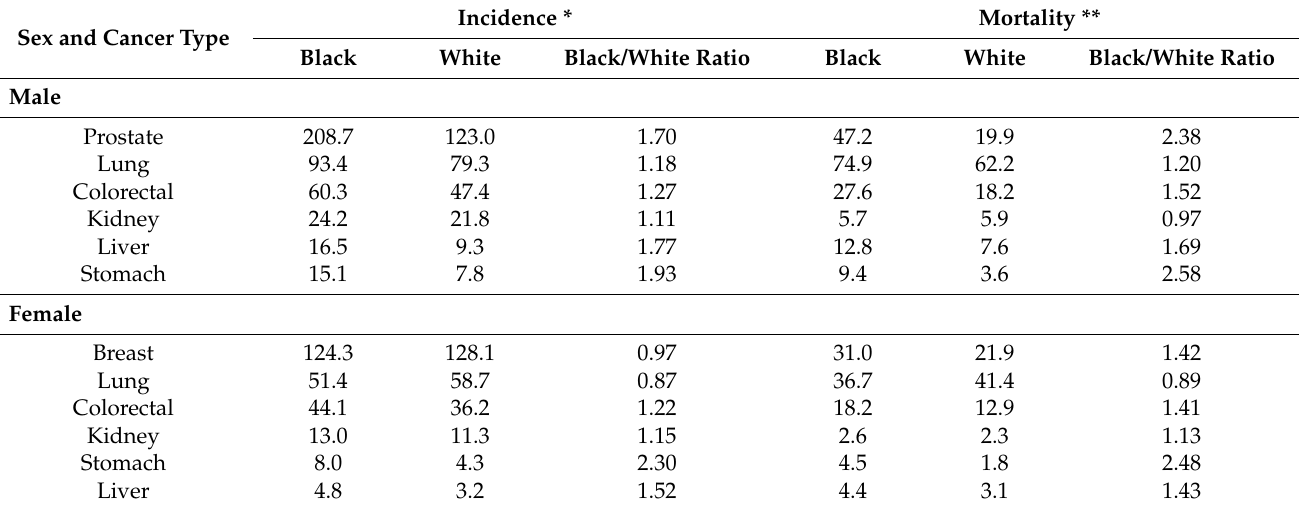
Table 2. Incidence and mortality rates for select cancers in the U.S. for males and females, 2008–2012 [74]. Incidence * Mortality ** Sex and Cancer Type Black White Black/White Ratio Black White Black/White Ratio Male